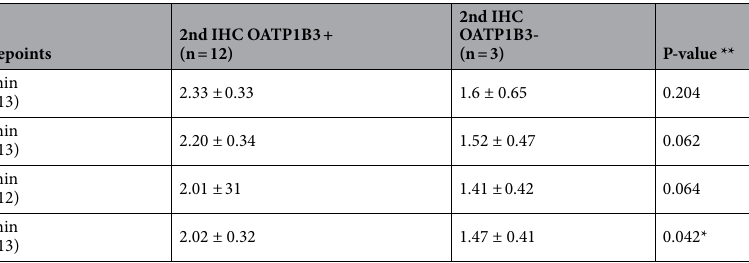
Table 3. Gadoxetate disodium enhancement based on OATP1B3 Expression on IHC. Total of 15 patients, 9 localized and 6 mCRPC. OAPT1B3 expression was associated with increased retention of gadoxetate disodium at 60-min timepoint. *Significant p value ** Statistical test used—Mann Whitney